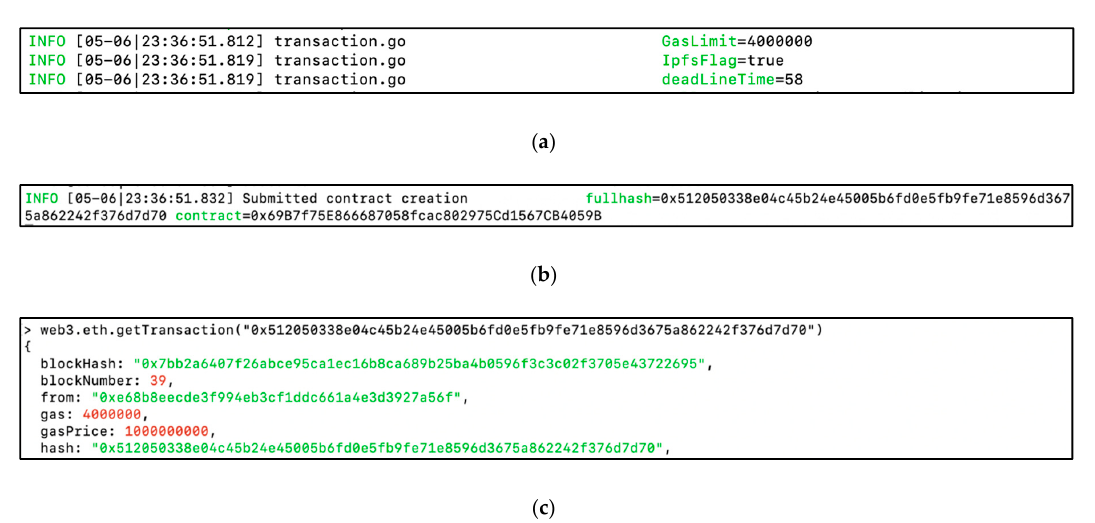
Figure 18. ( a ) Transaction with deadline time of 58, ( b ) full hash of the transaction, ( c ) gas limit 4,000,000 of the same hash.